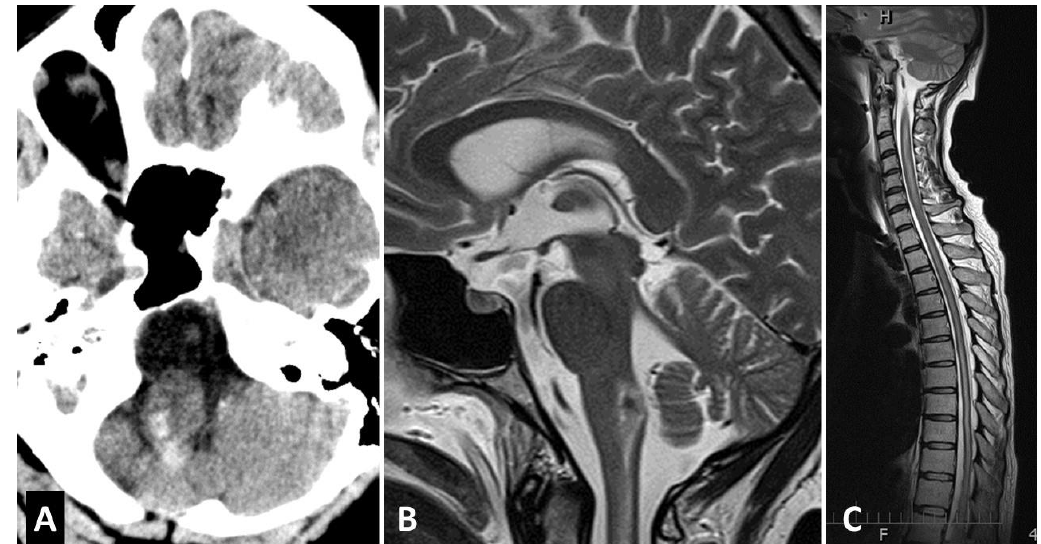
Figure 3. Brainstem hemorrhage. ( A ) Axial CT showed brainstem hemorrhage, ( B , C ) Sagittal T2—weighted MRI confirmed brainstem hemorrhage and revealed cervical and thoracic myelopathy.